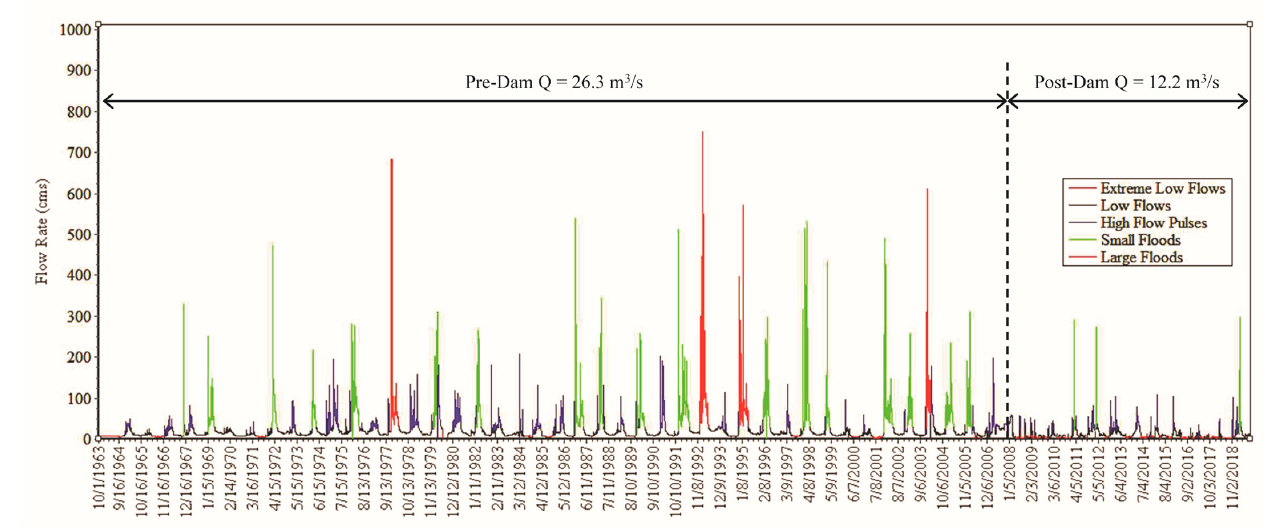
Figure 6. IHA environmental flow components of the Kor River showing the effect of Mollasadra Dam construction in 2008 on the river flow.